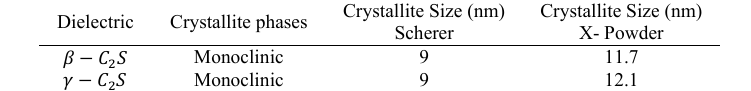
Table 4. Dimensions of dicalcium silicate nanocrystals